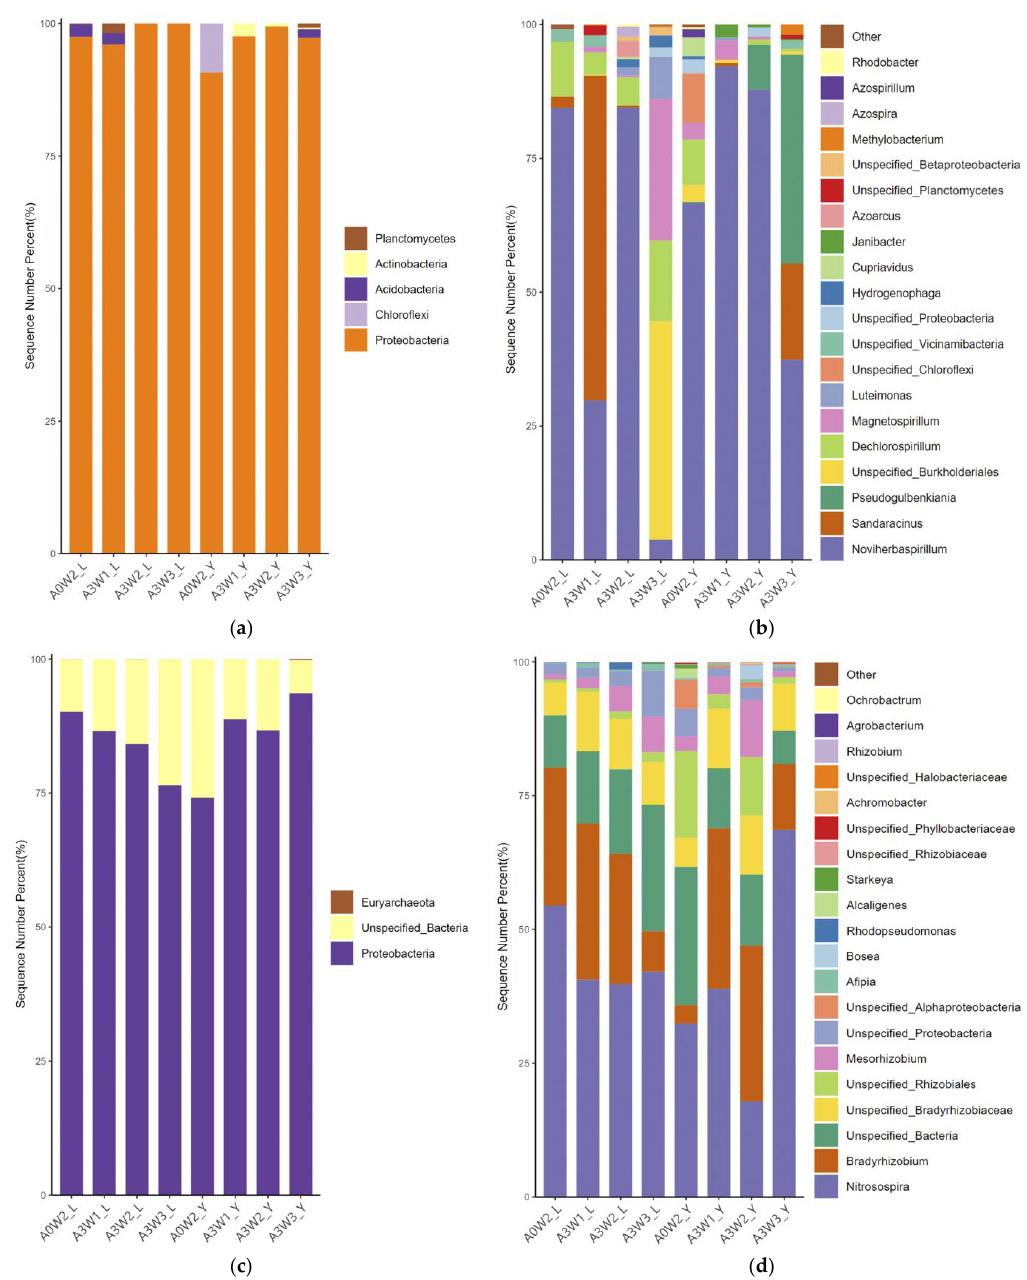
Figure 4. Relative abundance of nirS ( a , b ) and nirK ( c , d ) at the phyla and genera levels. A, the concentration gradient of the antibiotic sulfamethazine, including A0 (0 ng·L −1 ), A1 (500 ng·L −1 ), A2 (1500 ng·L −1 ), and A3 (3000 ng·L −1 ). W, irrigation methods, including W1 (flood irrigation), W2 (mild AWD), and W3 (severe AWD). _L and _Y indicate the late tillering and yellow ripening periods, respectively.